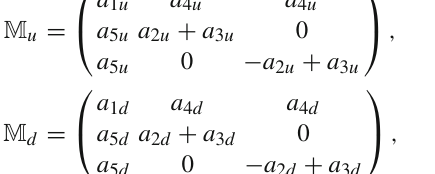
Table 3 Some model parameters in the case m 0 Parameters The derived